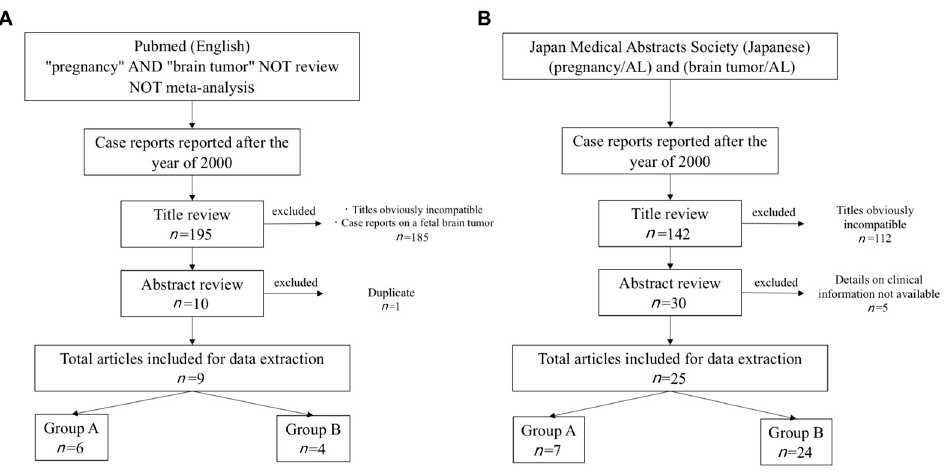
Figure 2. Literature search of PubMed and Ichushi-Web (Japan Medical Abstracts Society). ( A ) Literature search by PubMed. ( B ) Literature search by Ichushi-Web. The date of the last search was 30 July 2020. The search in Japanese was conducted by substituting English terms with Japanese synonyms. Table 1. The backgrounds and clinical findings of patients in the reviewed cases.